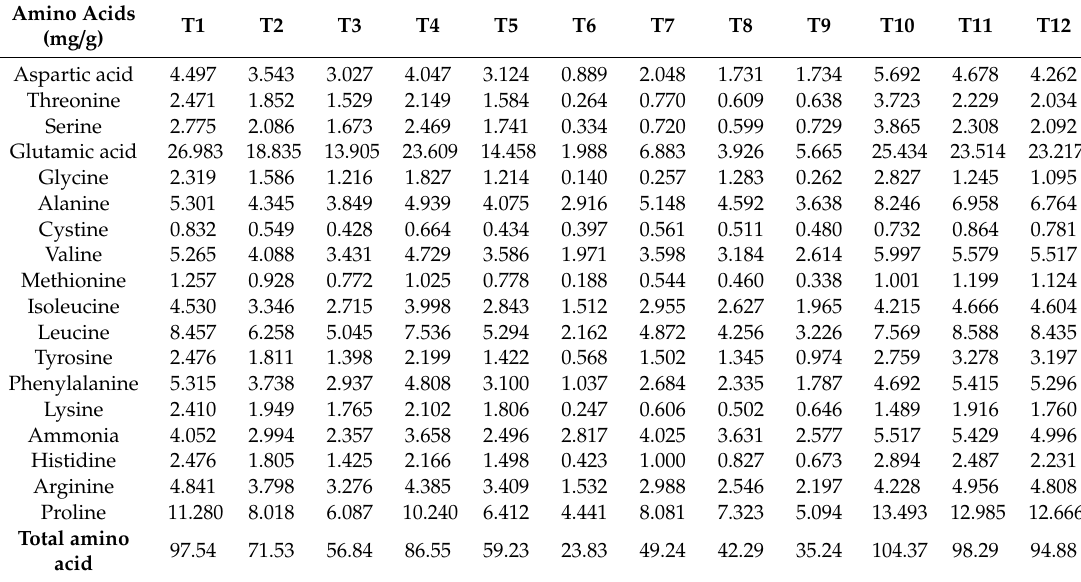
Table 5. Amino acid composition of wheat grain under di ff erent regimes of temperature, fertilizer type and soil moisture